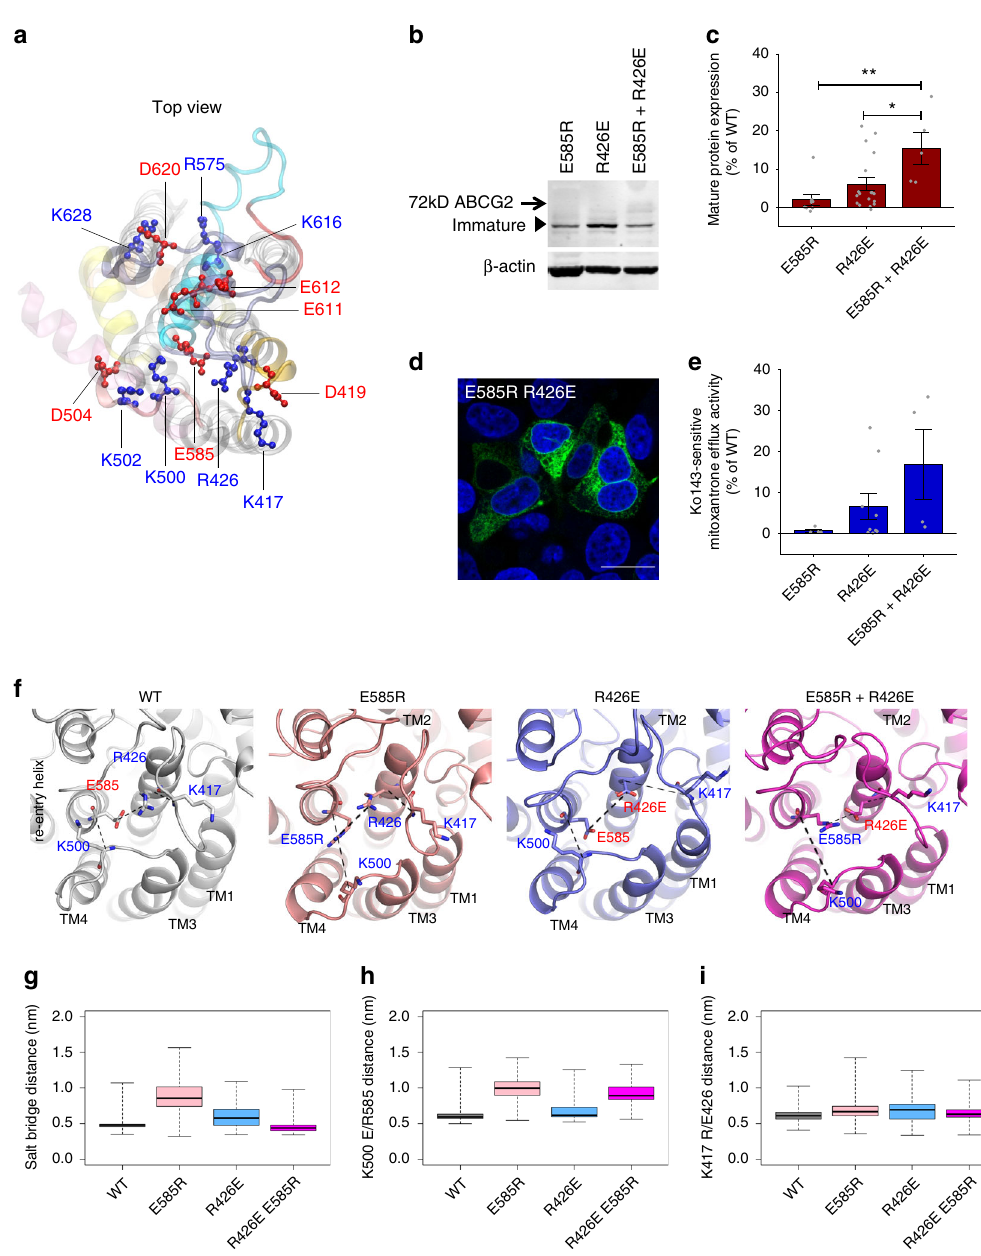
Fig. 3 Salt bridge interaction of charged residues stabilizes extracellular roof architecture. Charged residues in extracellular domains were mutated and transiently expressed in HEK293 cells. a Zoom-in top view shows side chains as ball-and-stick with the positions of negative (red) and positive charges (blue) in the roof. For clarity, ECL1 (gold), ECL2 (old rose), short loop after TMH5 (red), re-entry helix (cyan), ECL3 (violet), TMHs (gray), elbow helix (pink); the intracellular NBD was removed. b Immunoblot detection is shown for ABCG2 mutants using the anti-ABCG2 (BXP-21) antibody in HEK293 cell- free extracts. β -Actin served as an internal loading control. c Quanti fi cation of immunoblot is shown for ABCG2 variants ( n = 5 – 17). Data re fl ect fold- change relative to the WT control. All values are means ± SEM; ** P < 0.01; * P < 0.1. Gray dots represent independent biological replicates. d Intracellular localization of the GFP-tagged ABCG2 double mutant R426E E585R in HEK293 cells. The GFP-ABCG2 signal (green) and nuclei (blue) were detected using the Zeiss LSM700 confocal microscope. Scale bar in microscopy images corresponds to 20 µ m. e Mitoxantrone ef fl ux activity of ABCG2 mutants expressed in HEK293 cells are shown as percentage relative to WT control ( n = 4 – 9). Gray refer to independent biological replicates. f Conformation of WT, E585R, R426E, and double mutants, taken from the fi nal frames of MD simulations of inward-facing ABCG2, highlighting residues 426 and 585 and the interacting residues on ECL1 (K417) and ECL2 (K500). Dotted lines indicate distances. g Boxplot of distances measured between C δ of residue 585 and C ζ of residue 426 (boxes indicate second and third quantiles; the center line shows the mean, the dotted whiskers reach the extremes). h Distance boxplot observed between the C α of residues E585 of the re-entry helix and K500 of ECL2. i Distance boxplot between residue R426 and K417 on ECL1. Data were obtained and merged from three parallel independent simulations over 150 ns for mutants, 500 ns for WT, and shown for both ABCG2 halves at 1 ns space of sampling. The data in g – i were computed based on more than 9000 data